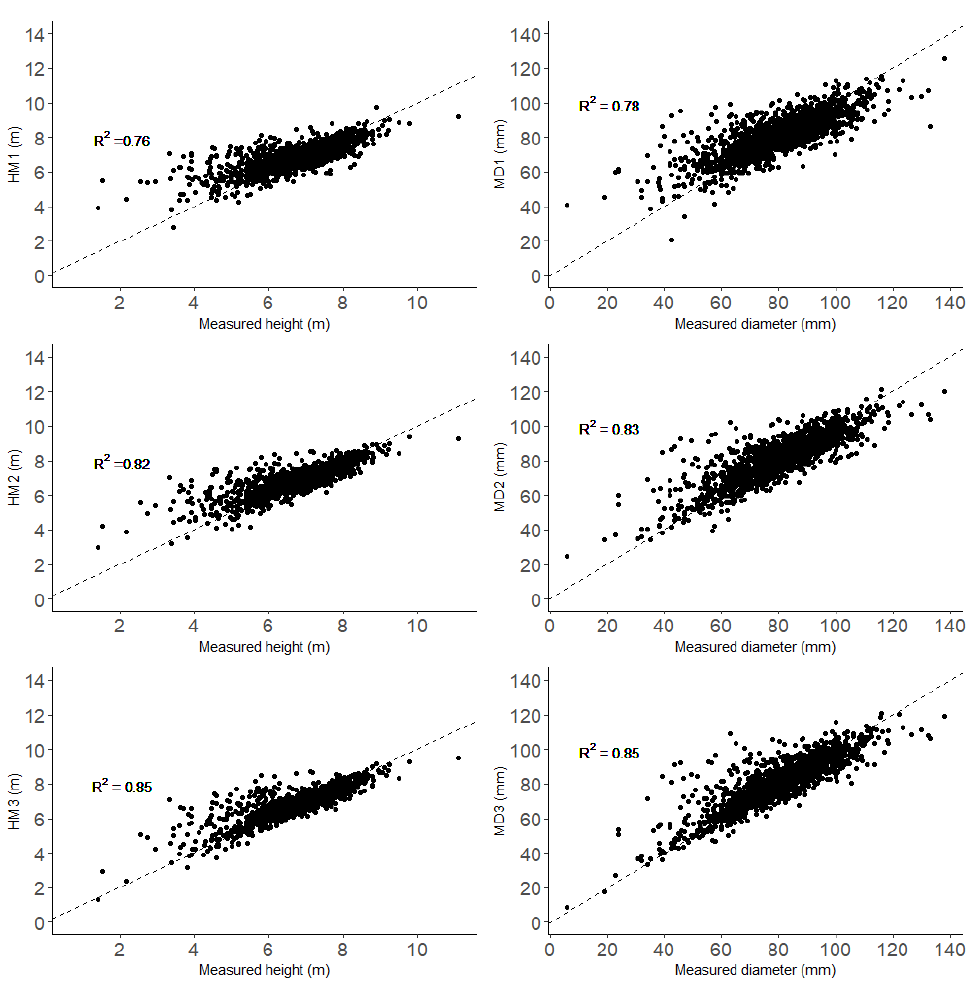
Figure 7. Genotypic means of height and diameter obtained from measurements (x-axis) and both the HM1–HM3 and DM1–DM3 models (y-axis). The dashed lines are regression lines with intercept = 0 and slope = 1.